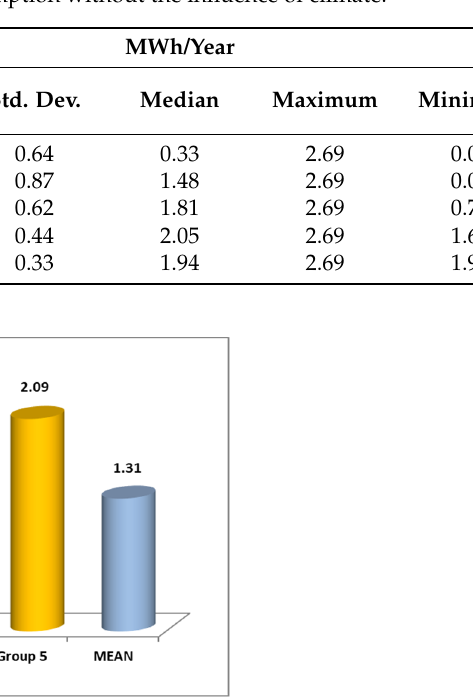
Figure 11. Mean energy consumption per household by group of cities without the influence of climate. Table 7. Statistical data of inhabitant consumption without the influence of climate.